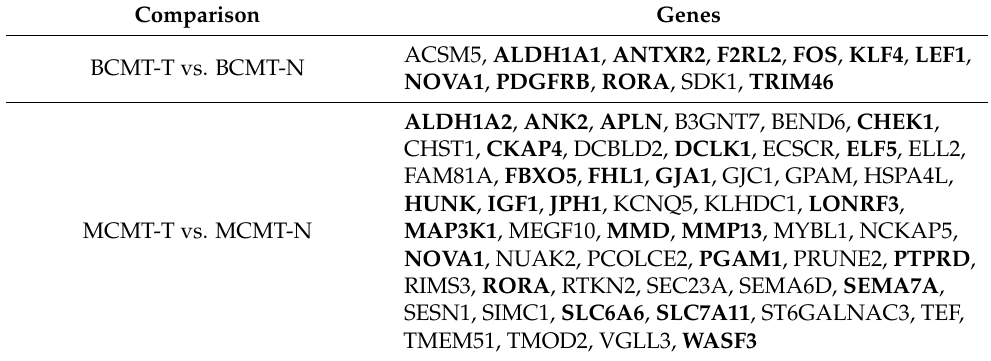
Table 2. Intersection and breast cancer related genes of miRNA and mRNA. Bold type indicates breast cancer related gene. Comparison Genes ACSM5, ALDH1A1 , ANTXR2 , F2RL2 , FOS , KLF4 , LEF1 , BCMT-T vs. BCMT-N NOVA1 , PDGFRB , RORA , SDK1, TRIM46 ALDH1A2 , ANK2 , APLN , B3GNT7, BEND6, CHEK1 , CHST1, CKAP4 , DCBLD2, DCLK1 , ECSCR, ELF5 , ELL2, FAM81A, FBXO5 , FHL1 , GJA1 , GJC1, GPAM, HSPA4L, HUNK , IGF1 , JPH1 , KCNQ5, KLHDC1, LONRF3 MCMT-T vs. MCMT-N